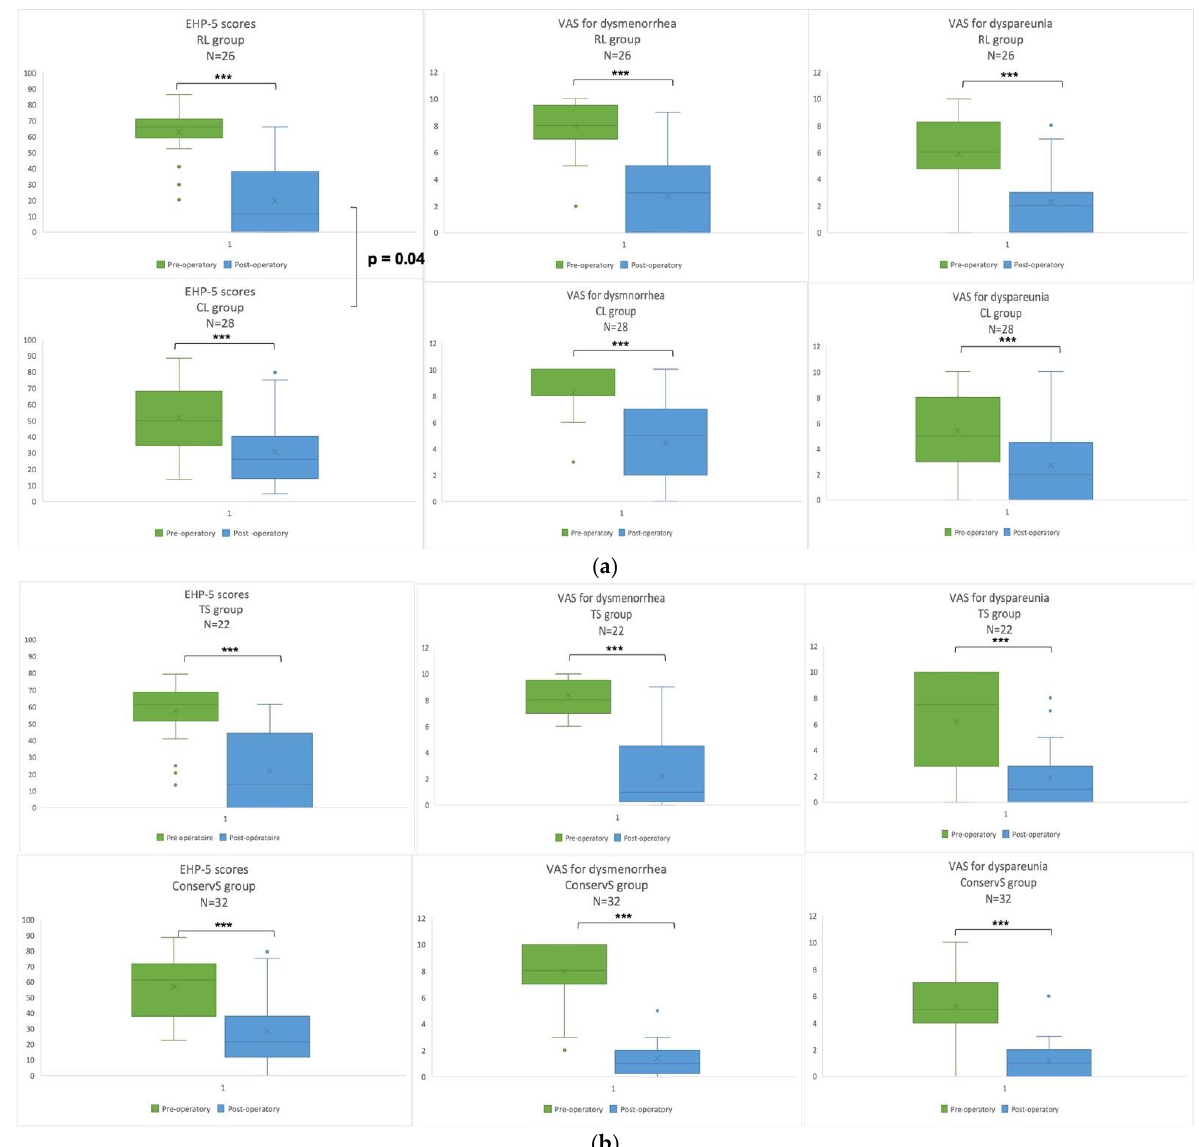
Figure 4. Figure 4.